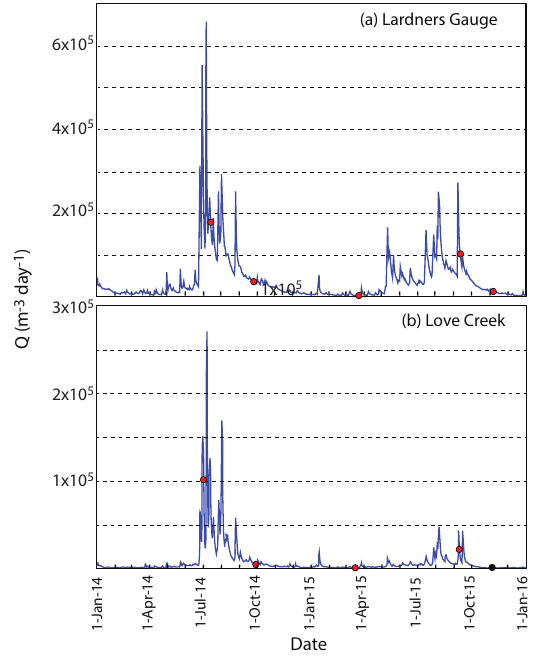
Figure 3. Hydrographs for Lardners Gauge (a) and Love Creek (b) together with the timing of sample collection. Data from Depart- ment of Environment, Land, Water and Planning